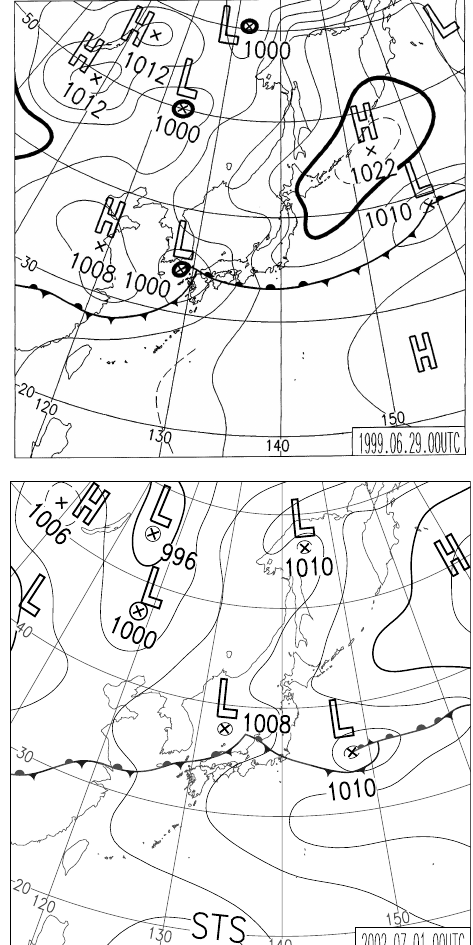
Fig. 4. Surface weather charts at 09:00 JST on 29 June 1999 and on 1 July